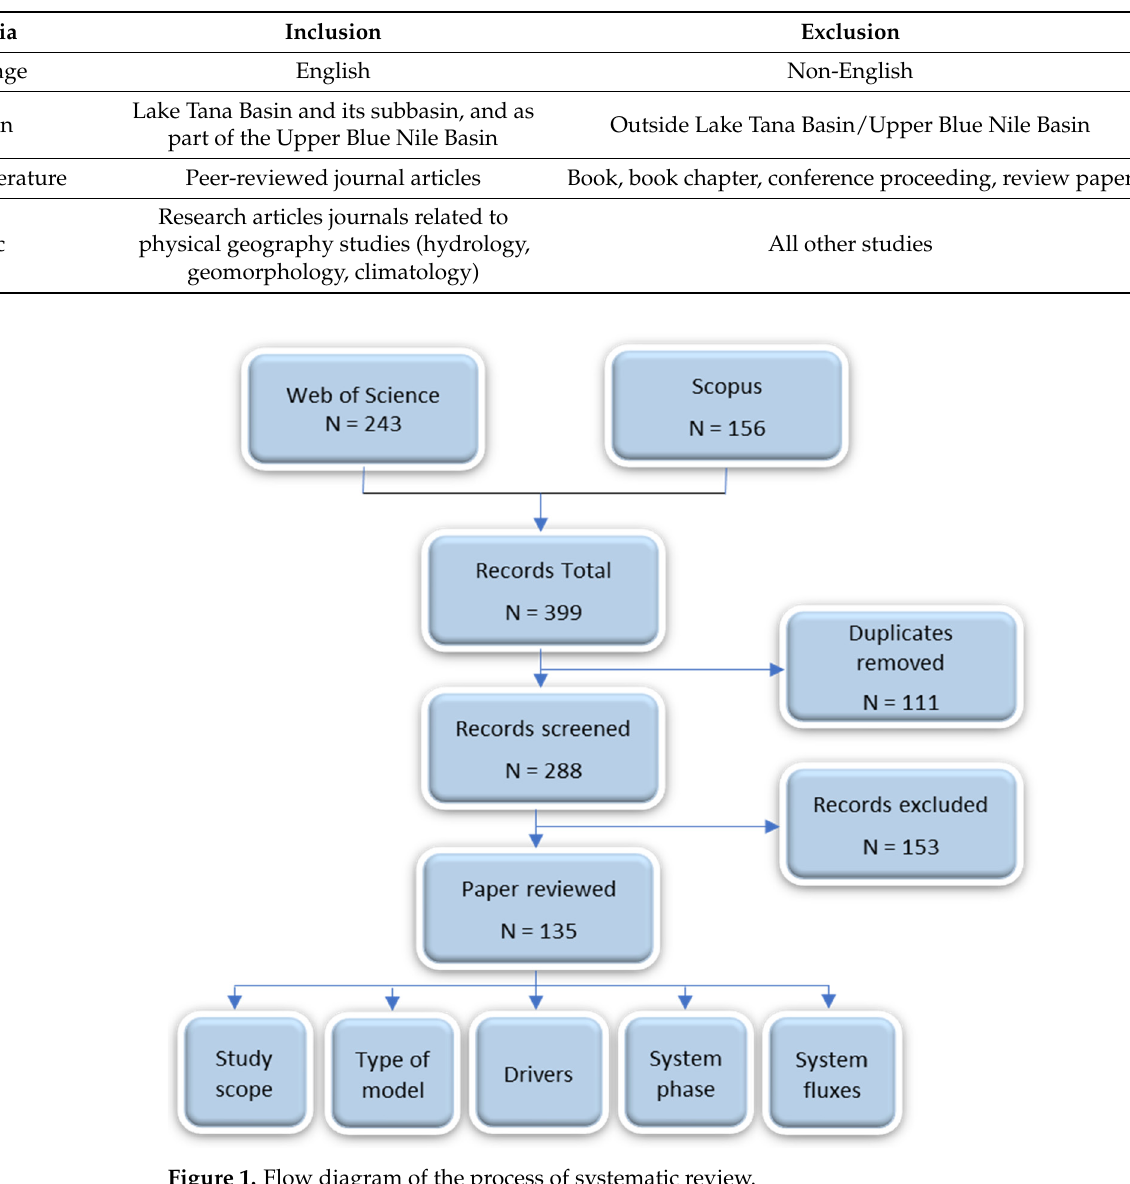
Table 2. Topic of focus considered to classify and analyze the 135 research papers relating to climate, hydrology and geomorphology of the Lake Tana Basin.